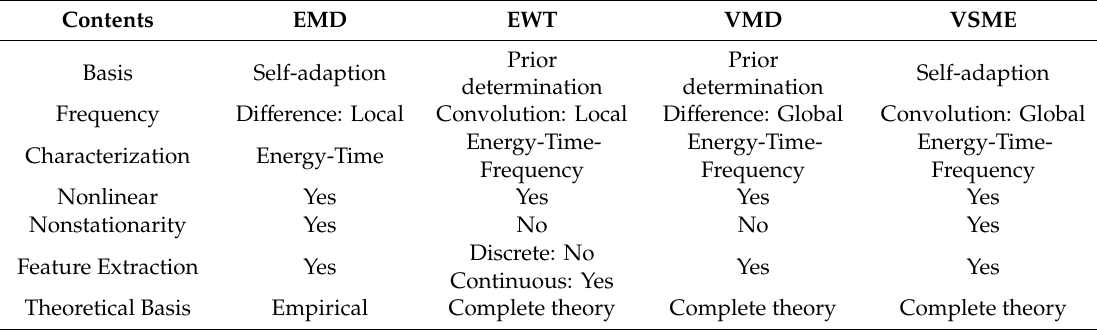
Table 1. Comparison of EMD, EWT, VMD and